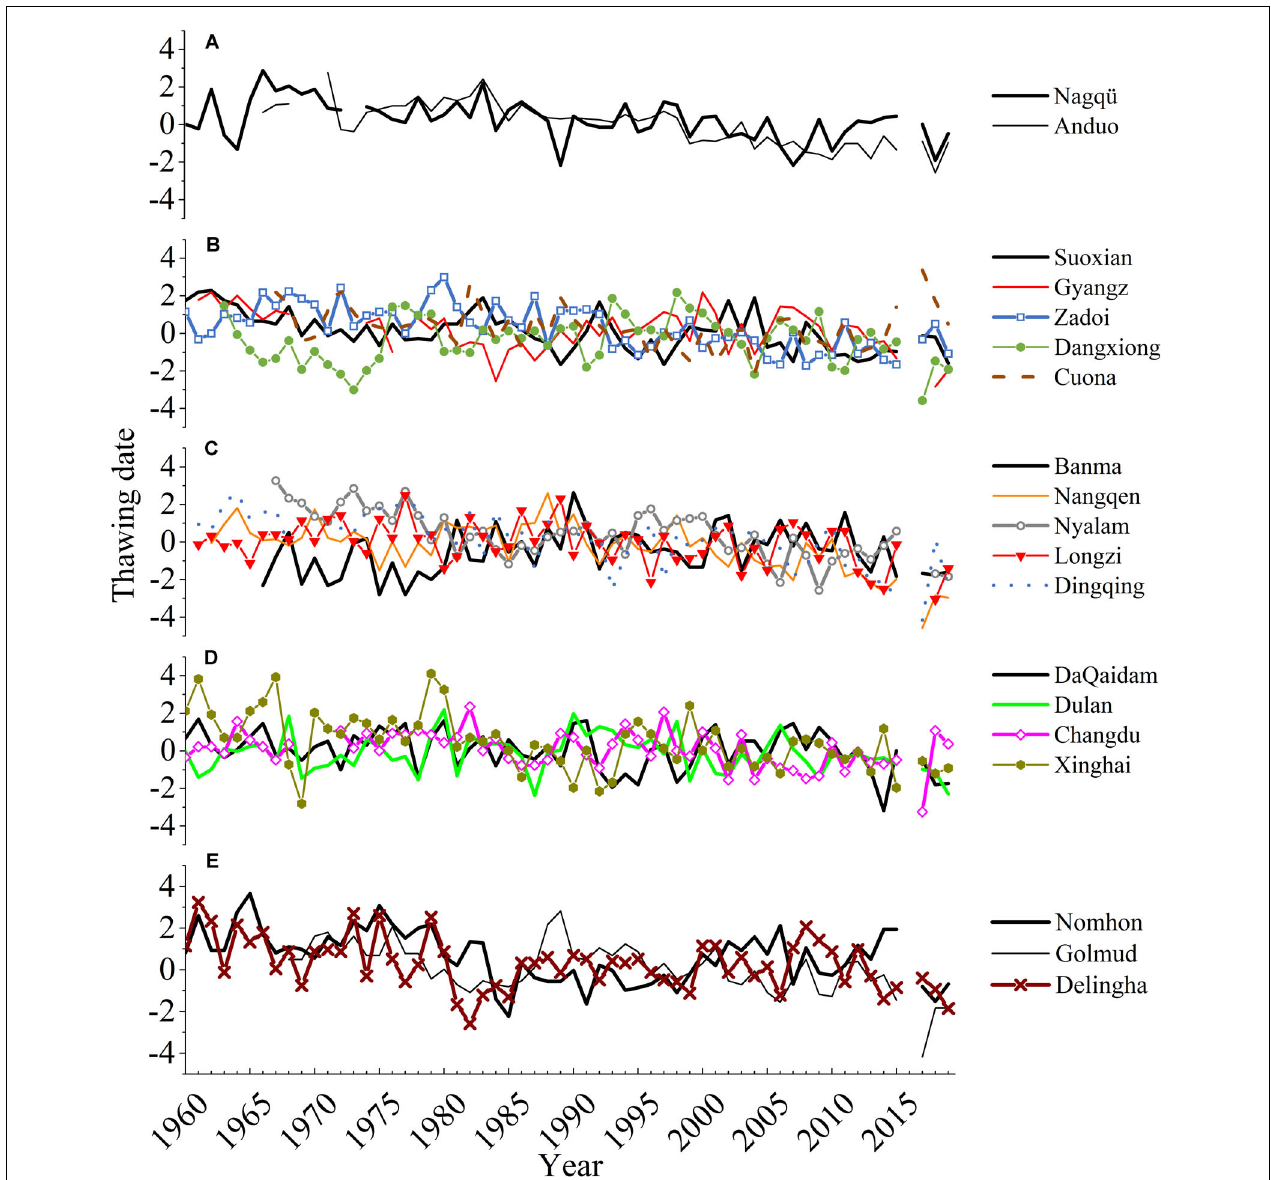
FIGURE 5 | Similar to Figure 3 , but for the date of disappearance of frost in the